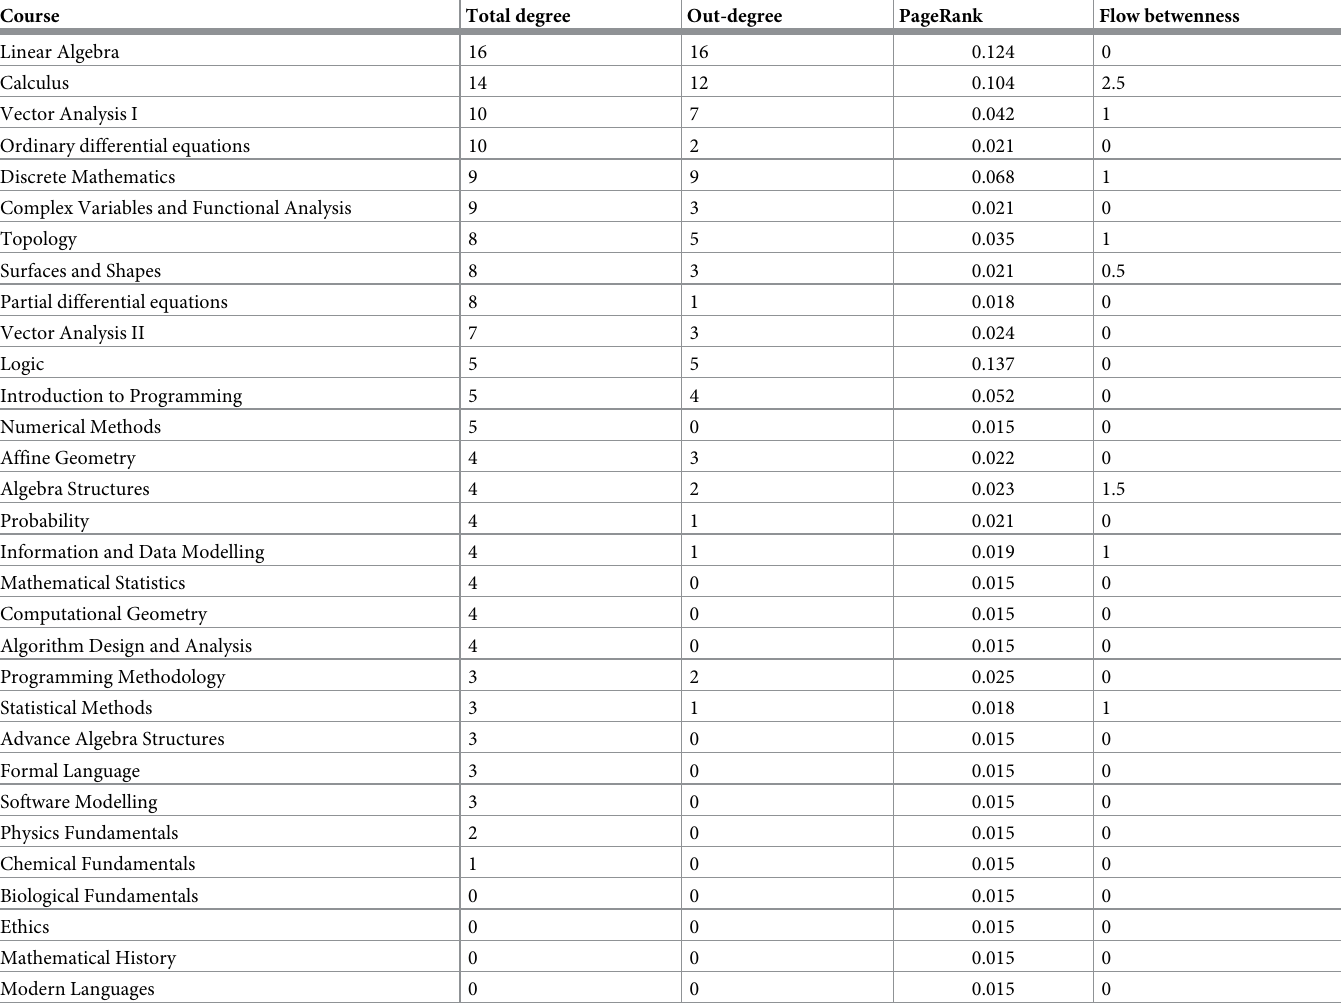
Table 3. Main centrality measures for the study plan of the URJC mathematics